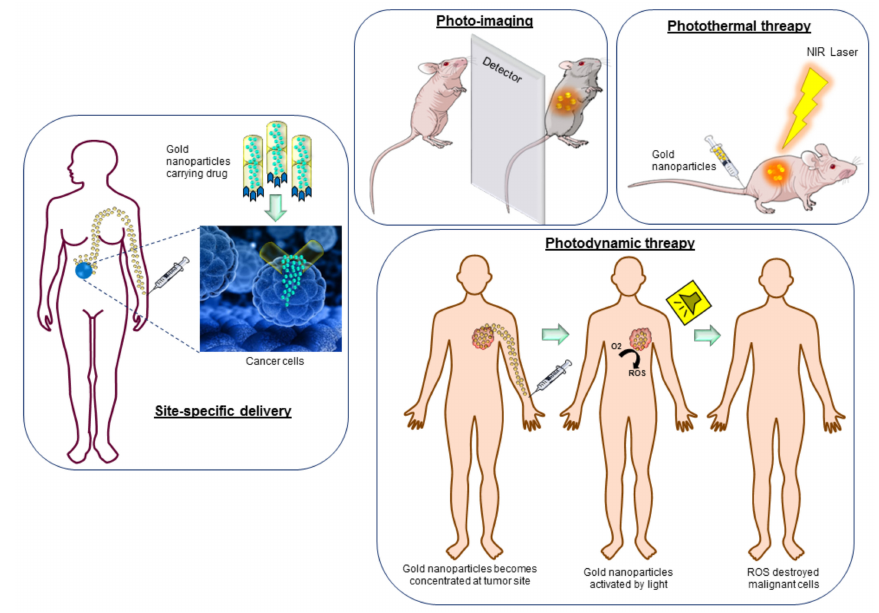
Figure 2. Different approaches of gold nanoparticles in cancer diagnosis and